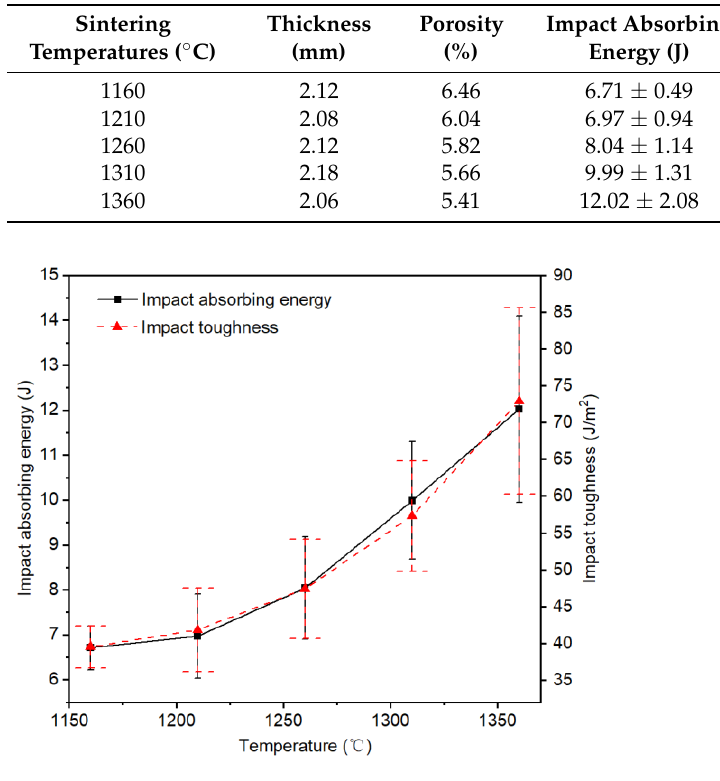
Figure 5. Variation trend of the impact properties of PWMCPPs with different sintering